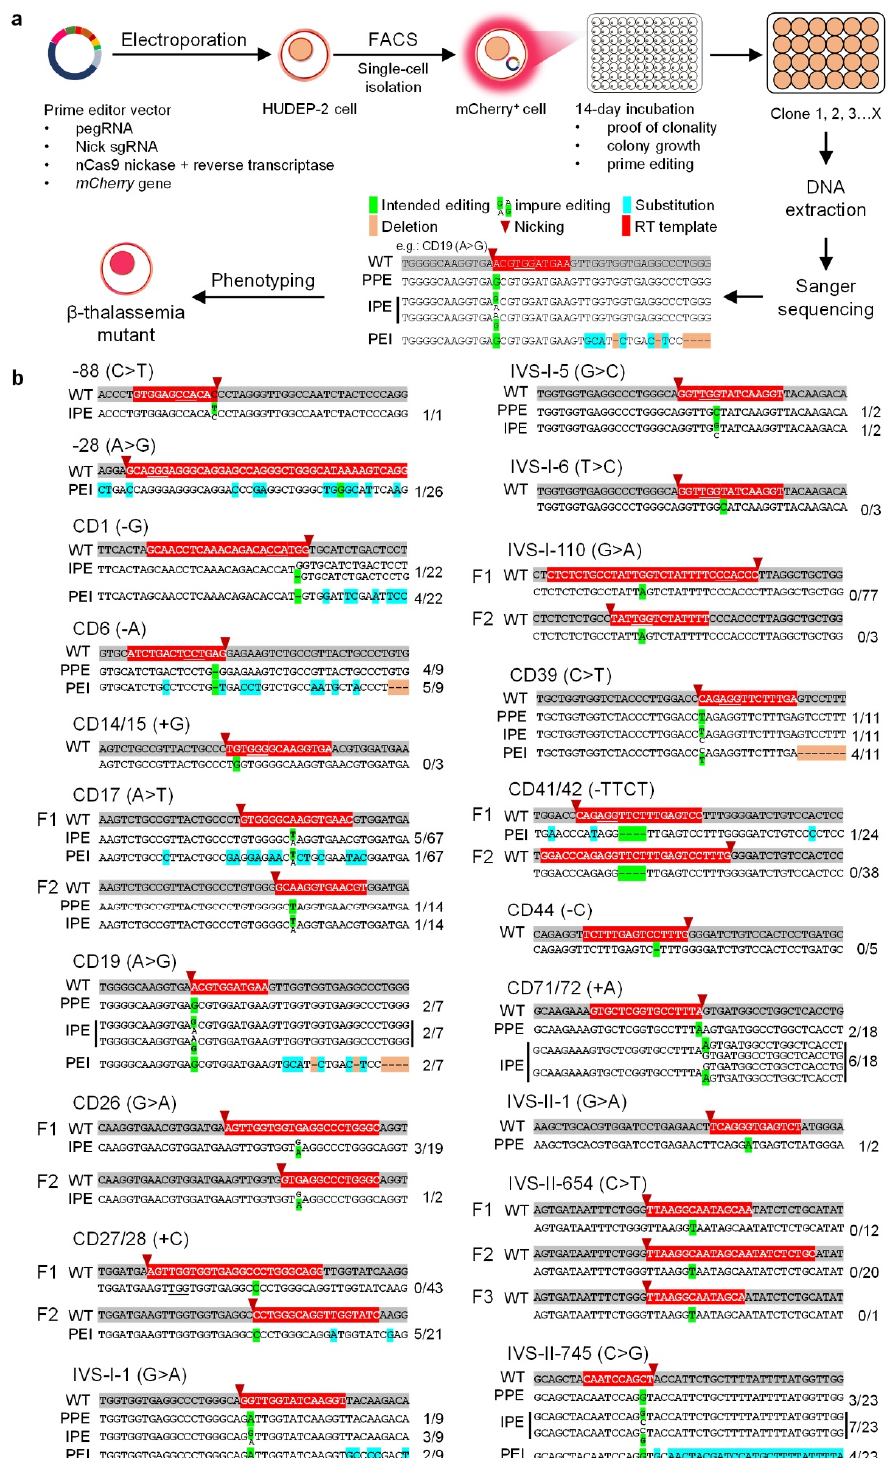
Figure 1. Installation of beta-thal mutations in HUDEP-2 cells using PE3. ( a ) Scheme of the workflow in this study. The constructed PE3 plasmids were utilized to install beta-thal mutations in HUDEP-2 cells. mCherry positive cells were sorted by FACS to rapidly detect PE3 modified HUDEP-2 cells that were selected for subsequent analyses. ( b ) The edits at each beta-thal mutation site, including editing position of pegRNA, Sanger sequencing result, sampling numbers, and the edit number.